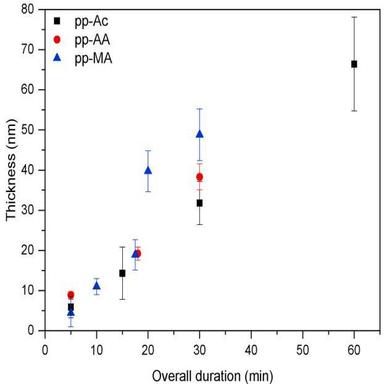
Dependence of the three plasma polymers thickness on the overall duration.